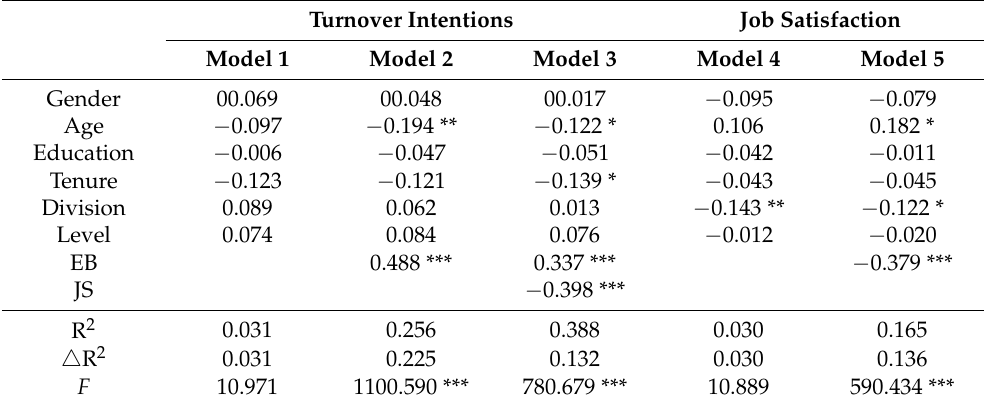
Table 5. The results of regression analysis.